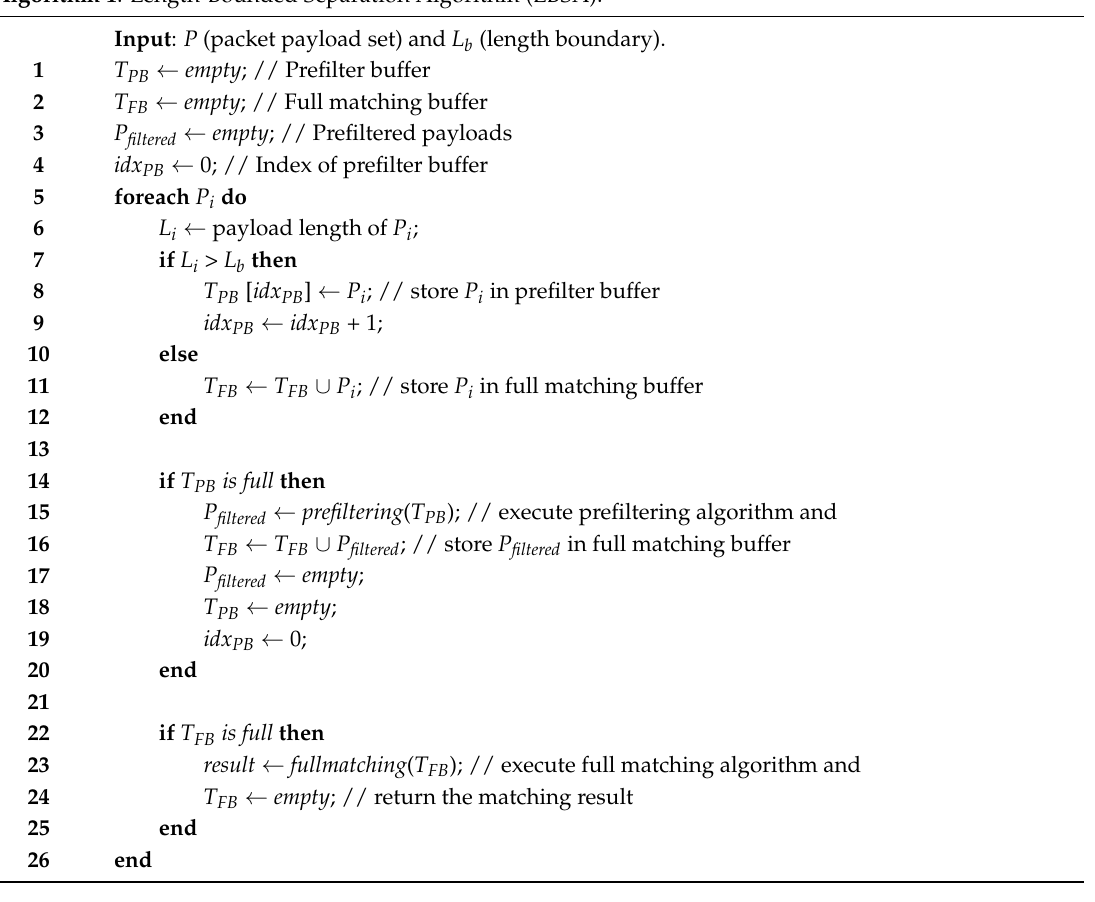
Algorithm 1 : Length-Bounded Separation Algorithm